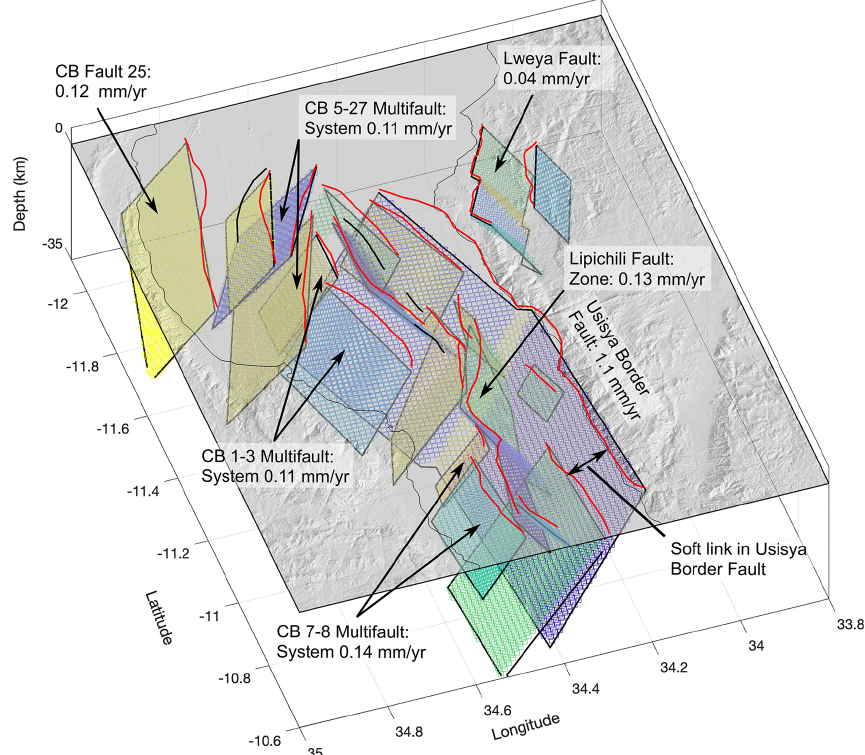
Figure 4. Perspective view of the Central Basin looking southwards and showing the simplified fault geometry in the MSSM geometric model (coloured planes) in relation to each other and to the present-day topography (light grey) derived from the SRTM DEM. Each coloured segment depicts a distinct planar source in the model (see Sect. 3.1.2 for a discussion on dip inferences). Red lines represent the equivalent fault traces in the MAFD (Williams et al., 2022b). Black lines represent the traces of faults in the MAFD that are not considered in the MSSM. Slip rates are annotated on key structures, and there is agreement between these estimates and preliminary estimates from measuring vertical offset of a prominent late Quaternary lowstand horizon in seismic reflection data (Wright et al., 2019).